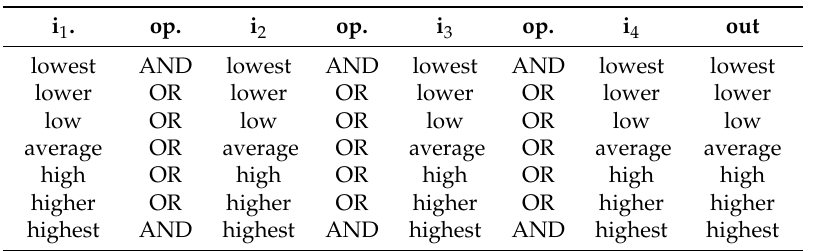
Table 2. Set of rules used by the FIS.